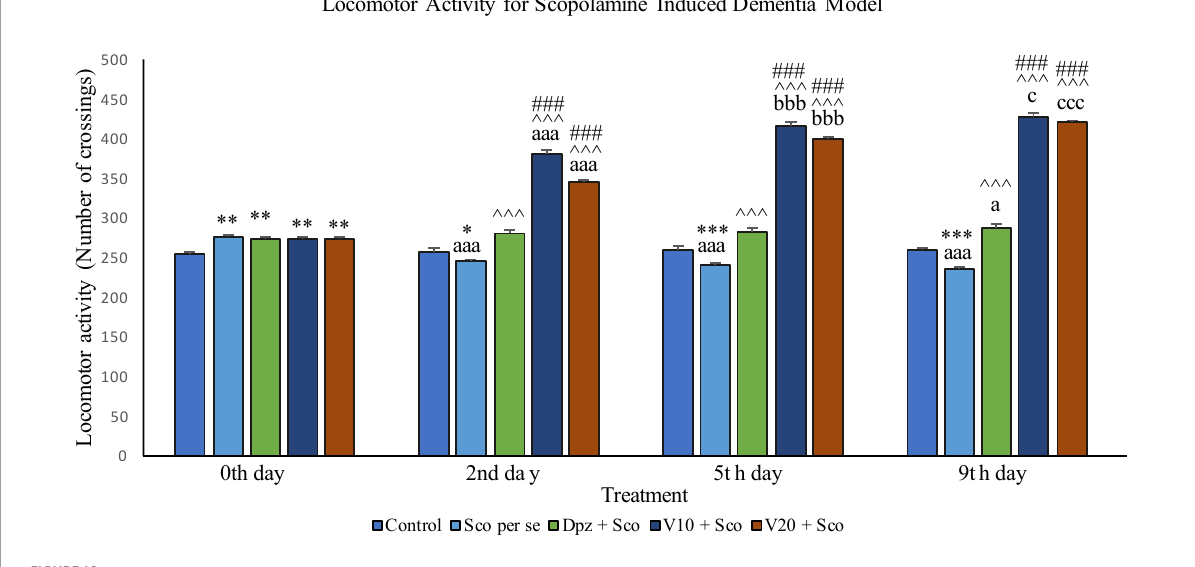
FIGURE12 Effect of vanillin and other treatments on locomotor activity. Data are expressed as mean ± SEM. “***” denotes P < 0.001 with respect to the control group within the same day, “**” denotes P < 0.01 with respect to the control group within the same day, and “*” denotes P < 0.05 with respect to the control group within the same day. “###” denotes P < 0.001 with respect to the standard treatment group within the same day. “ ∧∧∧ ” denotes P < 0.001 with respect to the negative control group (Sco per se ) within the same day. “aaa” denotes P < 0.001 with respect to the same group during the 0th day, and “a” denotes P < 0.05 with respect to the same group during the 0th day. “bbb” denotes P < 0.001 with respect to the same group during the 2nd day. “ccc” denotes P < 0.001 with respect to the same group during the 5th day, and “c” denotes P < 0.05 with respect to the same group during the 5th